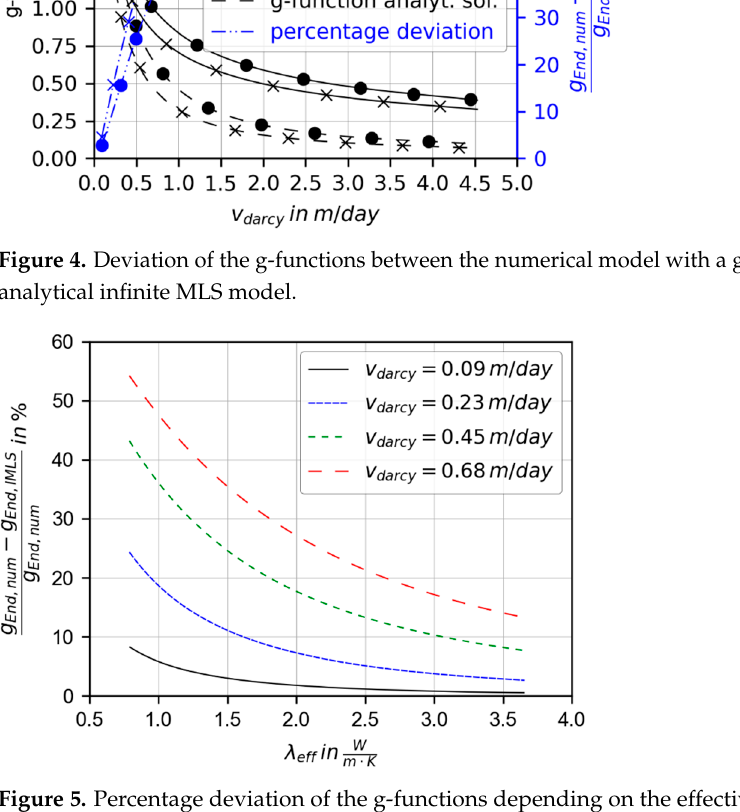
Figure 5. Percentage deviation of the g-functions depending on the effective thermal conductivity for different Darcy velocities.